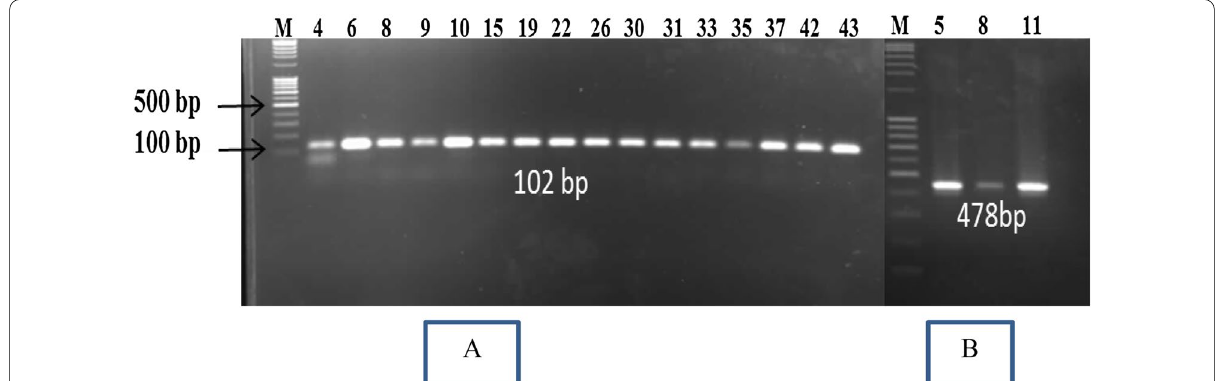
Fig. 2 The amplified products for SEA gene ( A ) and SEB gene ( B ) on 1.5% agarose gel electrophoresis which given positive with 16 isolates for SEA with 102 bp and positive with 3 isolates for SEB gene with 478 bp. A Lane M: DNA Ladder 100 bp (Thermo Scientific Fisher. USA), Lane 2 to Lane17: amplified products of 16 isolates for SEA gene. B Lane M: DNA Ladder 100 bp (Thermo Scientific Fisher, USA) lane 2 to Lane 4: amplified products of 3 isolates for SEB